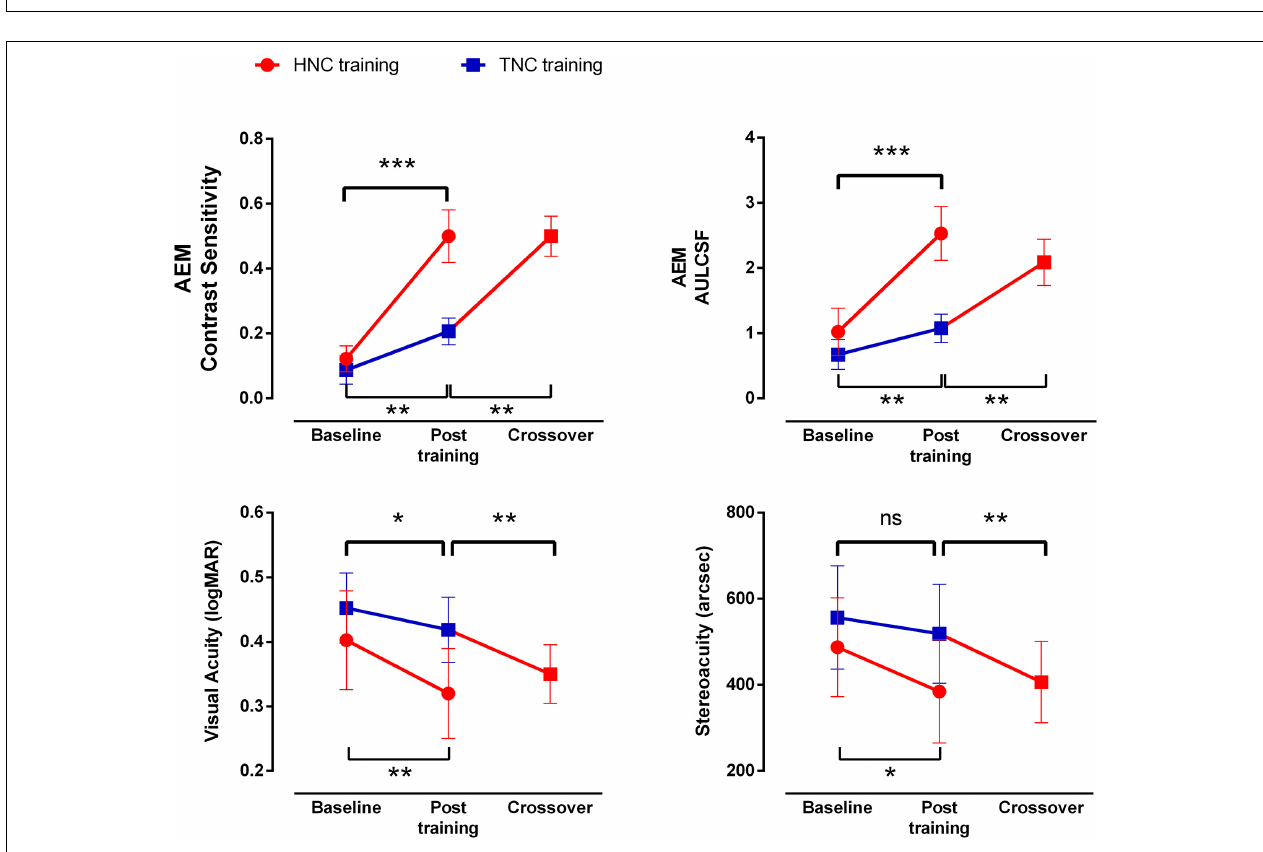
FIGURE 5 | Improvements in visual function after HNC vs. TNC training. Error bars represent SEM. * p < 0.05; ** p < 0.01; *** p < 0.001.